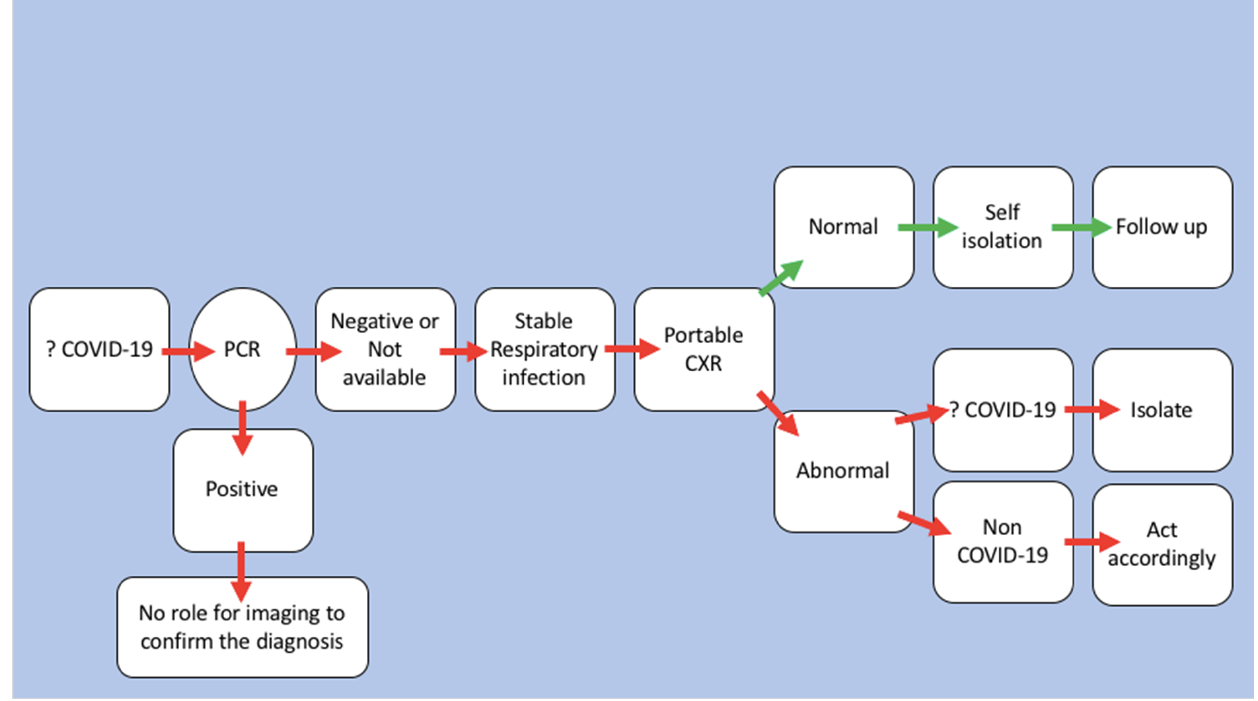
Figure 1. The role of imaging for patients suspected to have COVID-19 with stable respiratory infection (PCR: polymerase chain reaction, and CXR: chest X-ray).